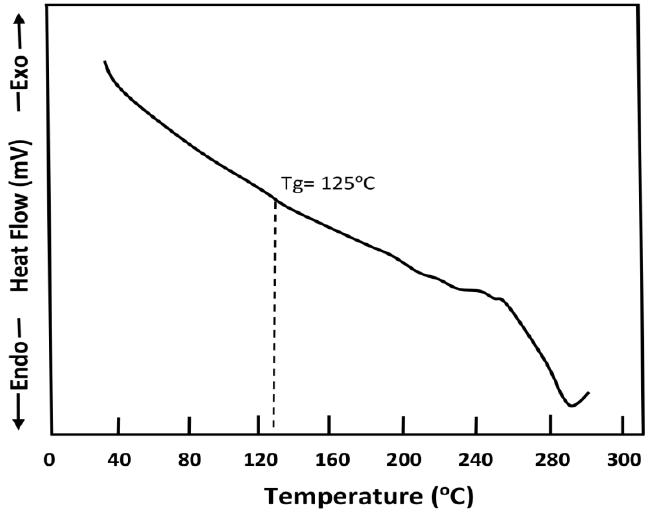
Figure 6. DSC thermogram of the prepared